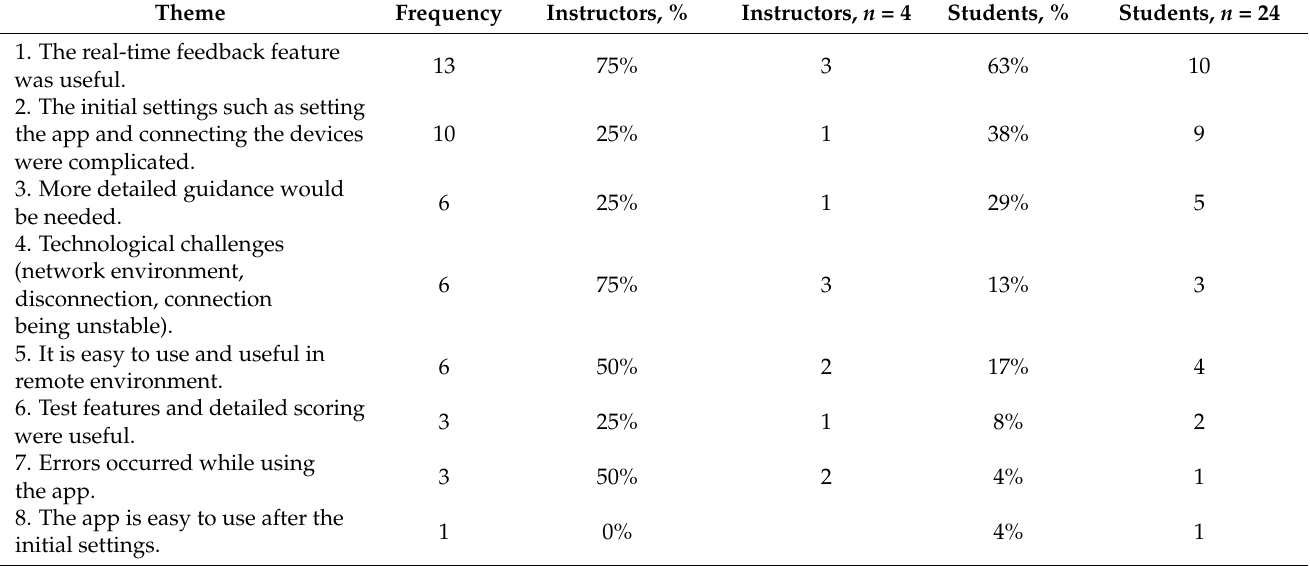
Table 4. Theme of Comment